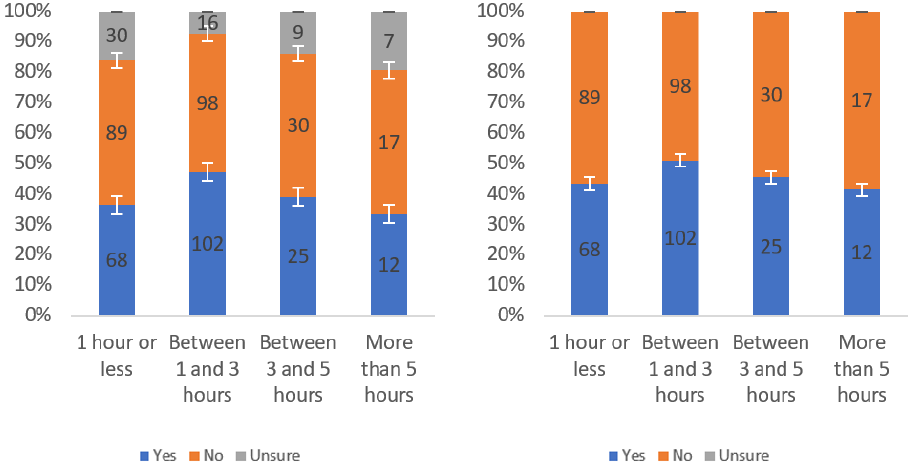
Figure A6. Responses regarding label annoyingness by internet usage level including ( left ) and excluding ( right ) unsure